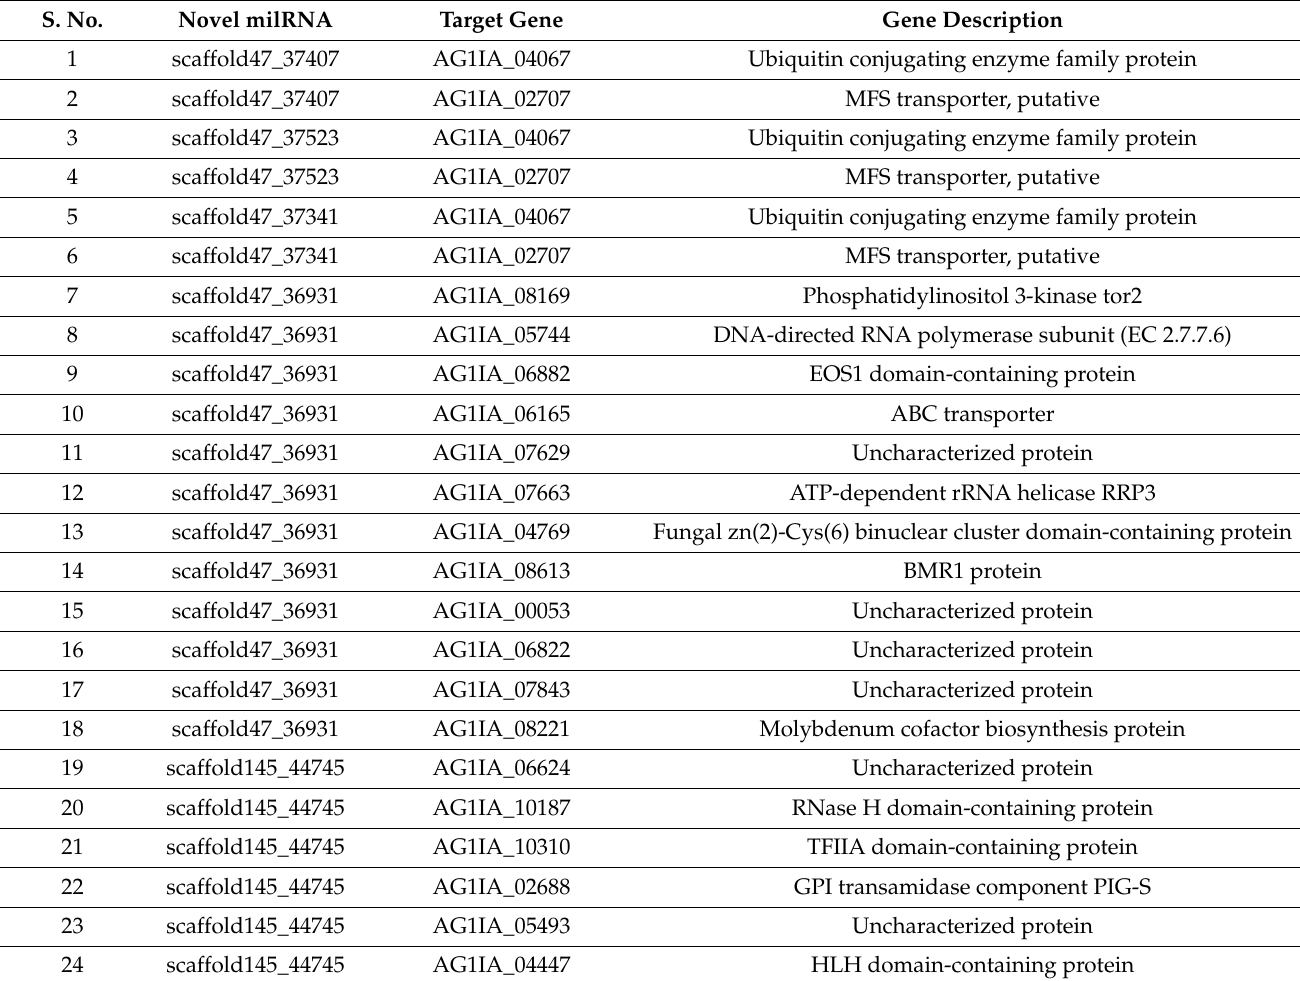
Table 3. Target genes of Rhizoctonia solani novel